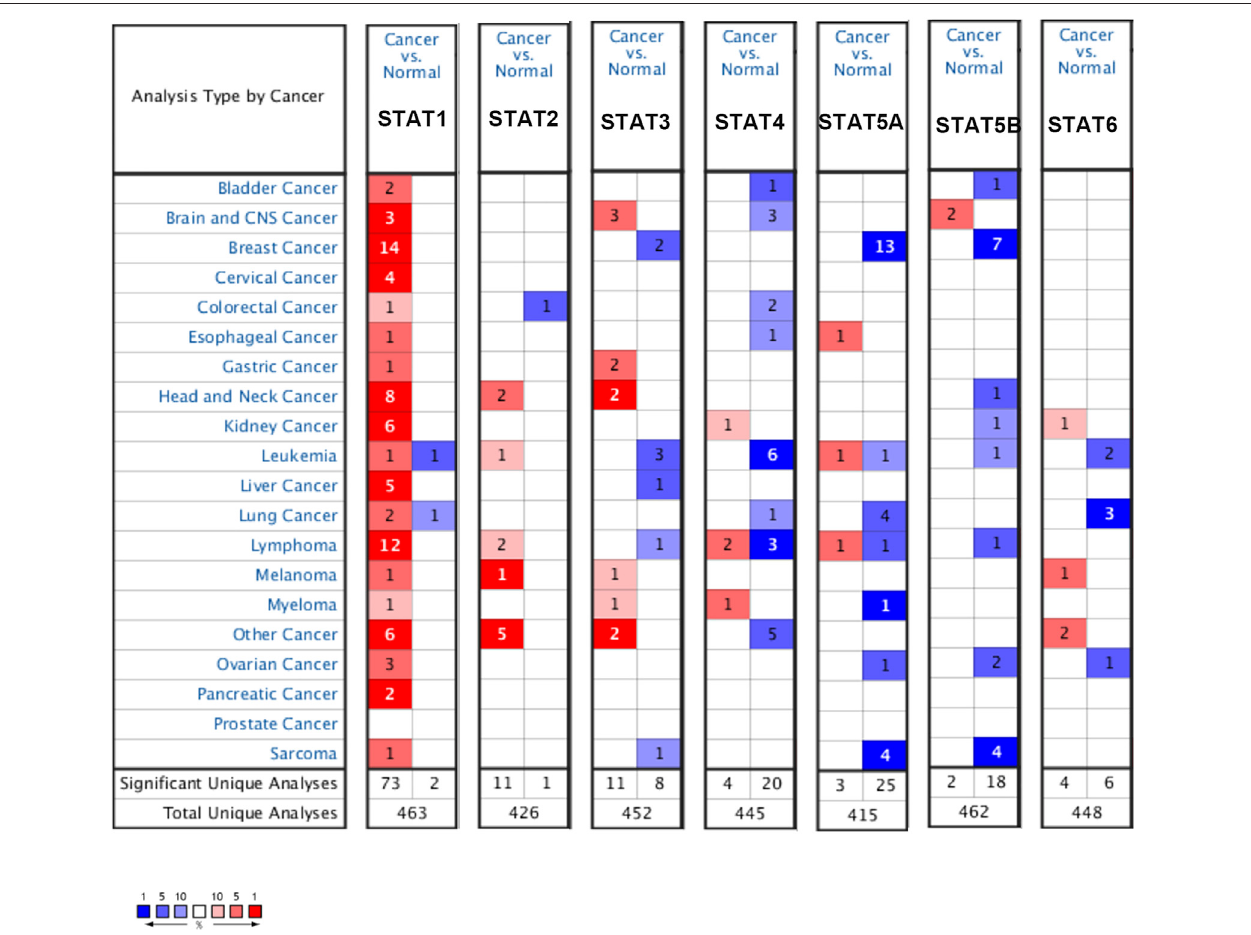
FIGURE 1 | Expression levels of the STAT family in different types of cancers (Oncomine). The panel shows the numbers of datasets with statistically signi fi cant mRNA overexpression (red) or downregulated expression (blue) of the STAT family. The threshold was designed with the following parameters: fold change of 1.5 and p -value of